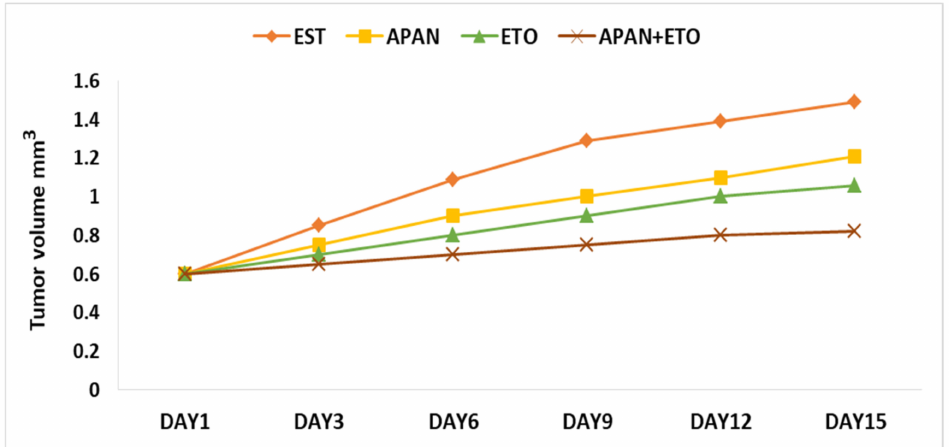
Figure 5. Chart representing changes in tumor volume vs. days over the course of mono (APAN or ETO) and dual treatment (APAN+ETO) against Ehrlich solid tumor-bearing mice